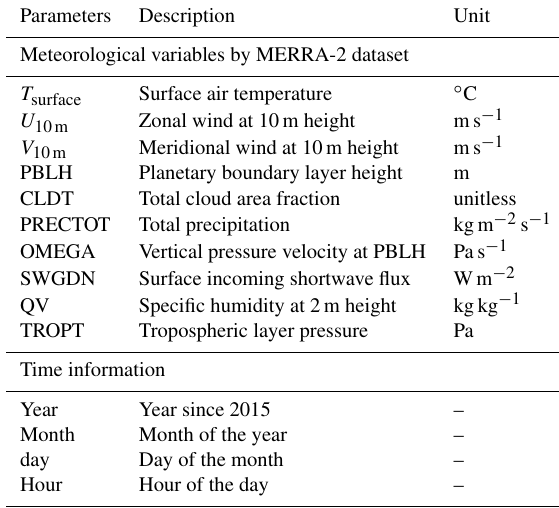
Table 2. List of predictive variables fed into the RF